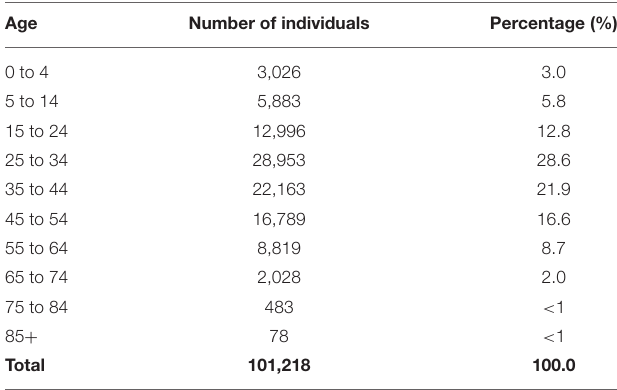
TABLE 2 | Percentage distribution of age among quarantined individuals under Amritham ( n = 101,218).